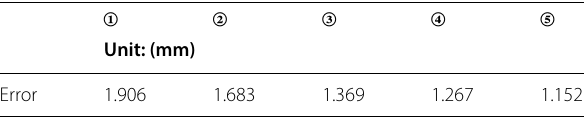
Table 1 Error between the estimated and the actual contact point